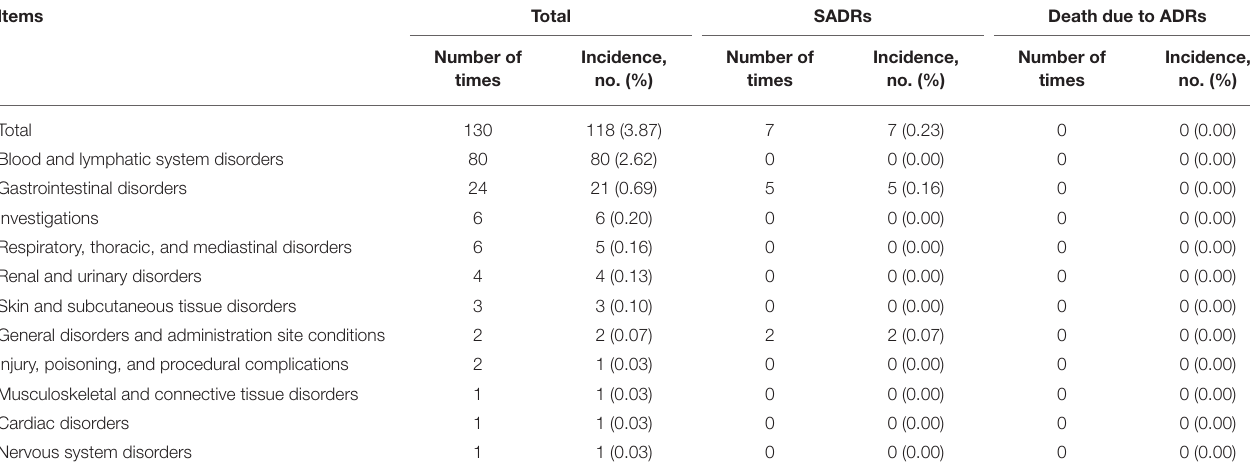
TABLE 3 | Detailed ADRs in System Organ Class